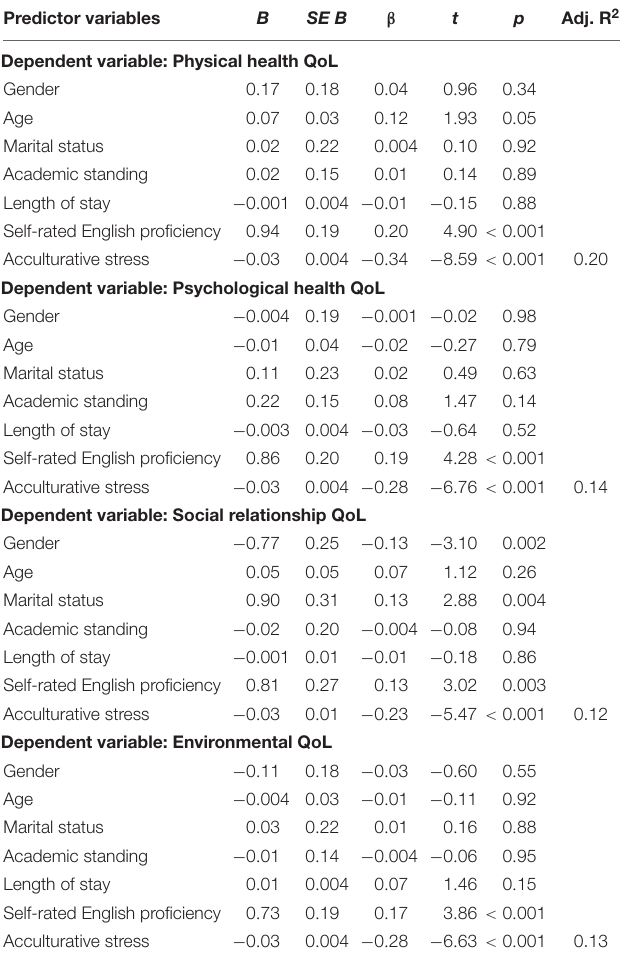
TABLE 2 | Multiple regression analyses of key research variables ( N =